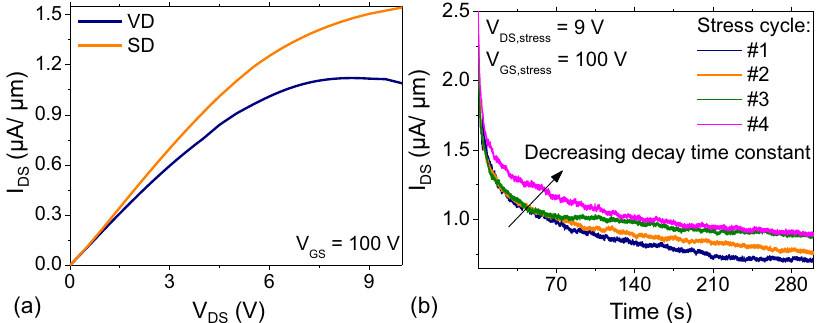
Fig. 8 Evidence of LTES-triggered perturbations in thermal transport properties of MoS 2 . a MoS 2 FET exhibits current saturation at a higher critical fi eld after being subjected to LTES. This implies that electrically stressed MoS 2 dissipates heat generated by electron – phonon scattering better than its virgin counterpart and therefore velocity saturation occurs at a higher critical fi eld. b Electron – phonon scattering-induced self-heating is suppressed in MoS 2 after multiple LTES cycles. This is inferred from the observed monotonic decrease in the current decay time constant and perpetual increase in the saturation current value after every stress cycle. This suggests that MoS 2 channel becomes a better heat spreader after experiencing long-term electrical